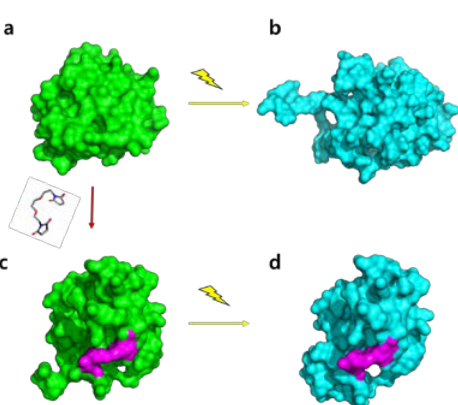
Figure 5. Schematic illustration of the structural changes in PYP induced by small-molecule binding ( a → c ) and blue light irradiation ( a → b , c → d ). ( a ) The dark state of wild-type PYP. ( b ) The light state of wild-type PYP. ( c ) The dark state of SML-PYP. ( d ) The light state of SML-PYP. The small-molecule linker is shown in magenta. Wild-type PYP dark and light structures are from PDB (protein data bank) ID, 2PHY and 2KX6, respectively, and the dark and light structures of SML-PYP are from this